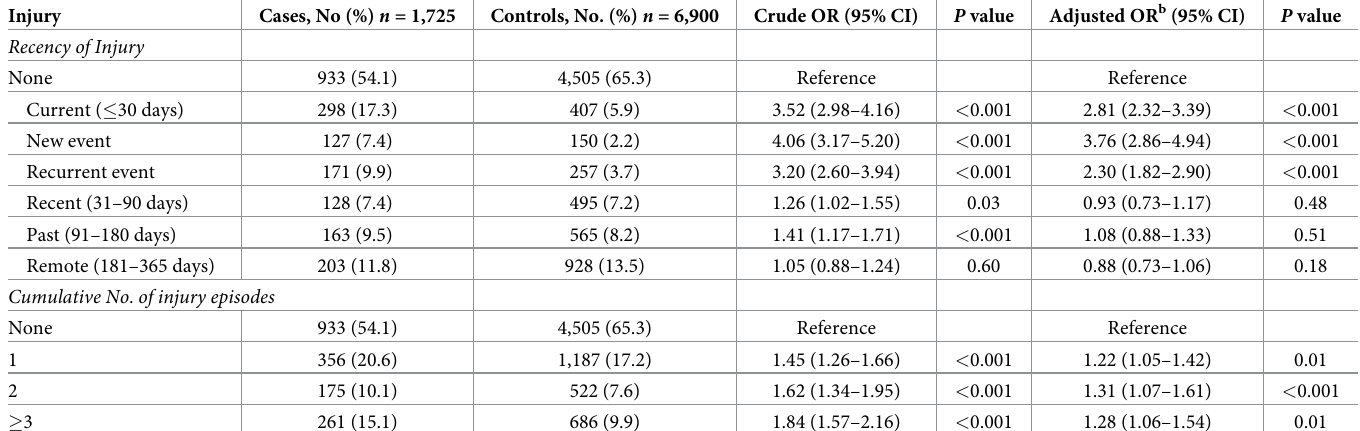
Table 3. Risk of ORAEs by recency and cumulative number of injurious episodes in the year before the index date a .